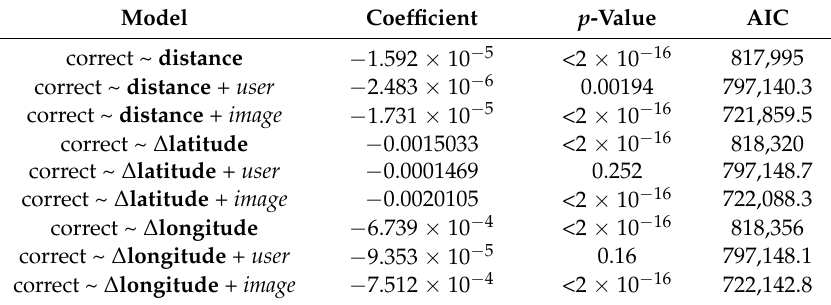
Table 1. Key results from different models of the probability of correct answers on a game-based cropland-identification task. The negative coefficients indicate that user performance is worse with greater distance from their home. In the ‘model’ column, items in bold are predictor variables whose coefficients and p-values are given in the subsequent columns. Items in italics are random effects included to control for possible variation in individual volunteer skill (user) or task difficulty (image). Units for distance are in kilometers and ∆ latitude and ∆ longitude are in degrees. A total of n = 2,065,714 observations spread among 151,756 images and 301 users were used in these models.